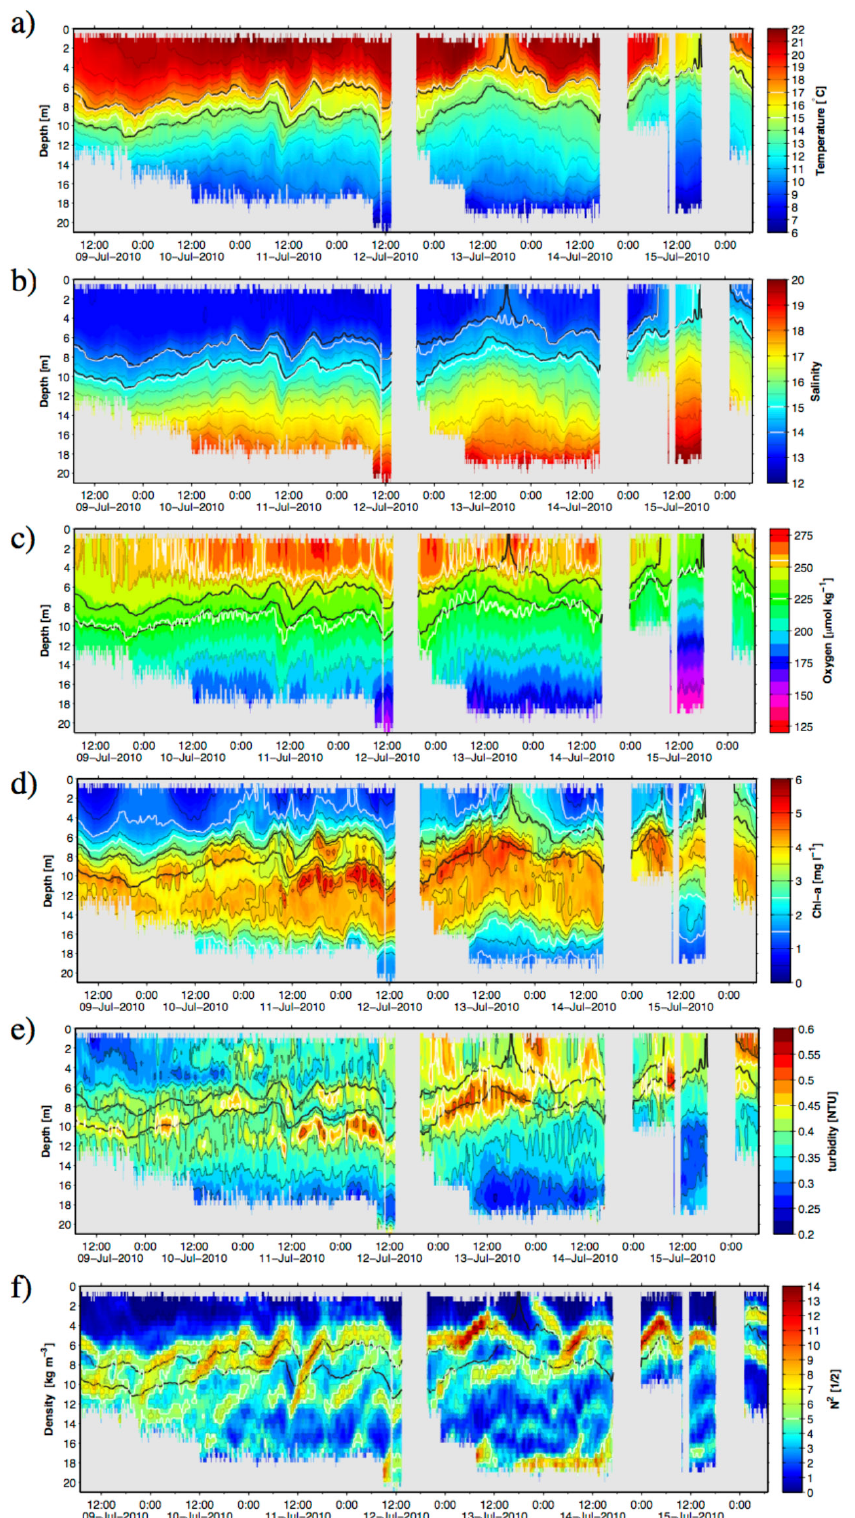
Figure 2. (a) Temperature, (b) salinity, (c) oxygen, (d) chlorophyll a /fluorescence, (e) turbidity and (f) buoyancy frequency from the glider survey. The grey areas indicate no data recordings. The white contours show selected parameter isolines (see individual colour bars). The two outcrop densities 1009.5 and 1010.7kgm − 3 are indicted by black